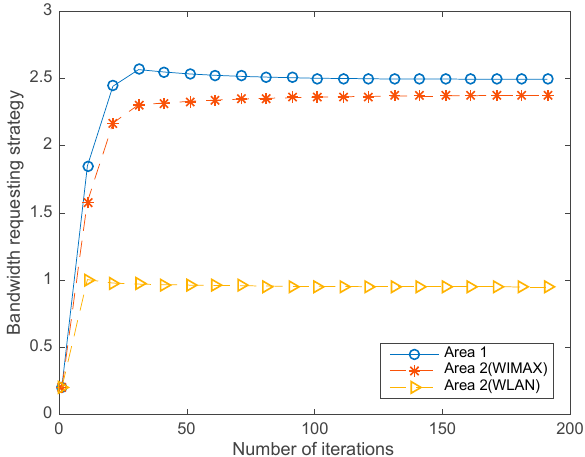
Figure 4. Bandwidth requesting strategy with the number of iterations.